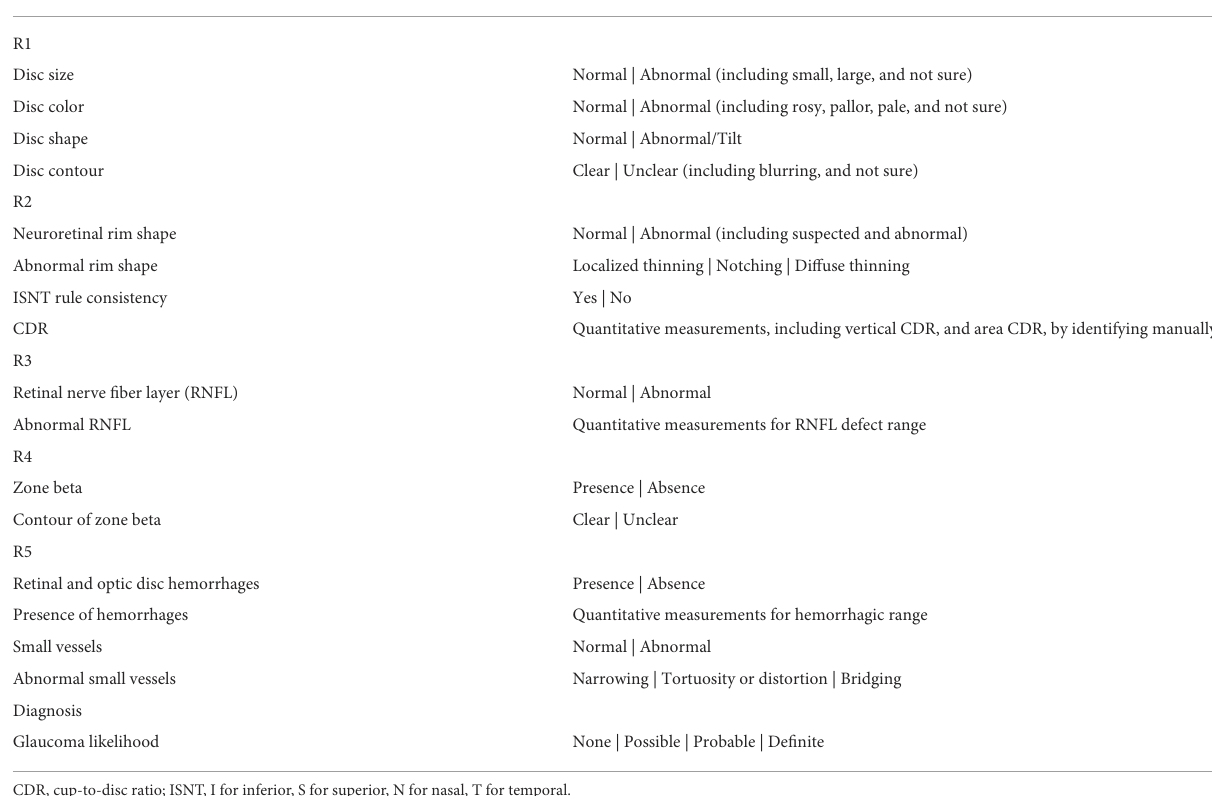
TABLE 1 Evaluation scale of morphologic characteristics and glaucoma diagnosis based on the Five R’s Rules and 4-subcategory glaucoma likelihood classification. Morphologic characteristics based on Five R’s Rule